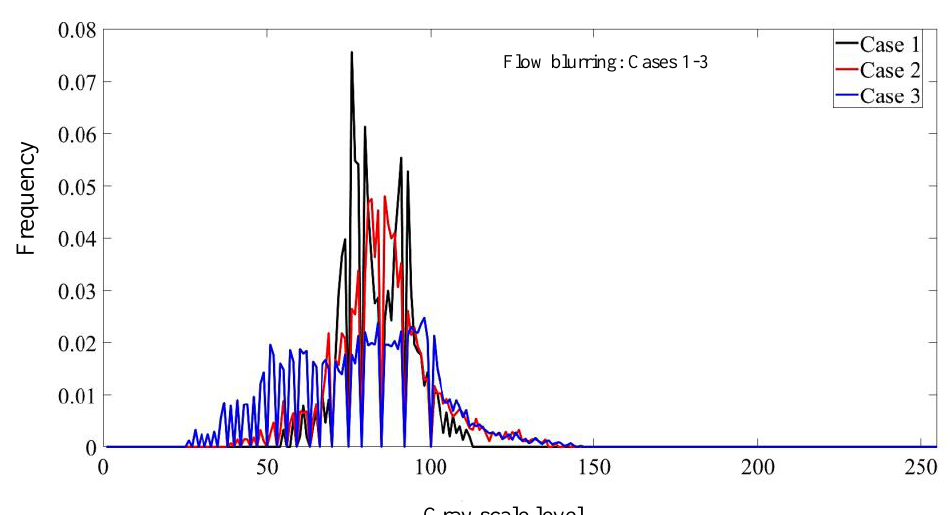
Figure 10. The gray distribution curves of the two-phase flow images under different orifice diameter: the water flow rate, air flow rate and tube-hole distance are 100 mL/min, 100 L/min and 1 mm, respectively. For cases 1 to 3, the orifice diameter is 3 mm, 5 mm and 7 mm, respectively.